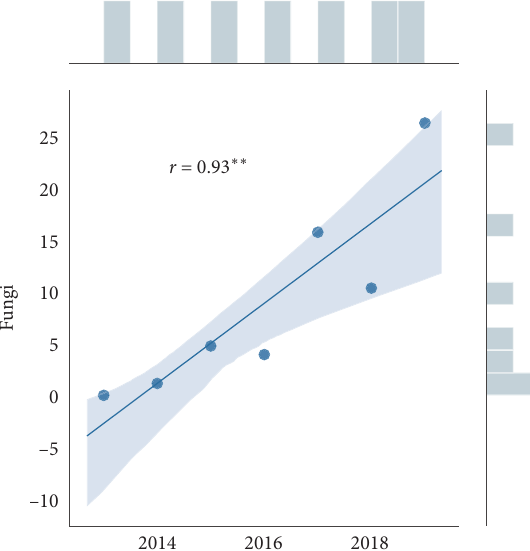
Figure 1: The matrix of correlations a.